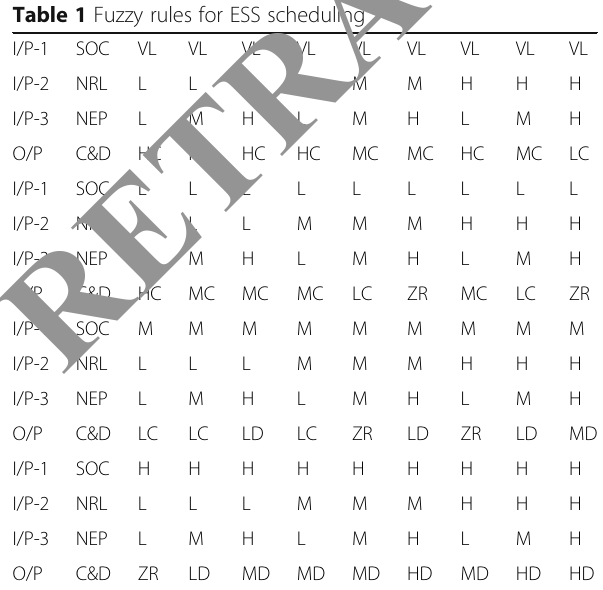
Table 1 Fuzzy rules for ESS